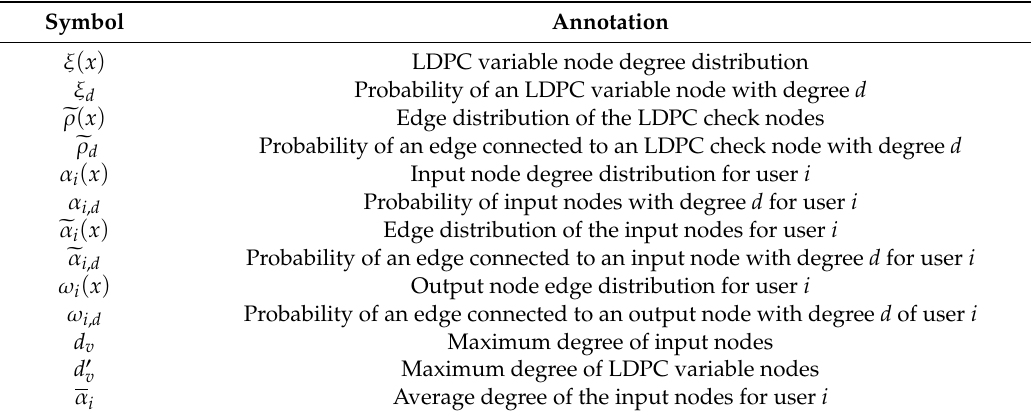
Table 1. Annotations to